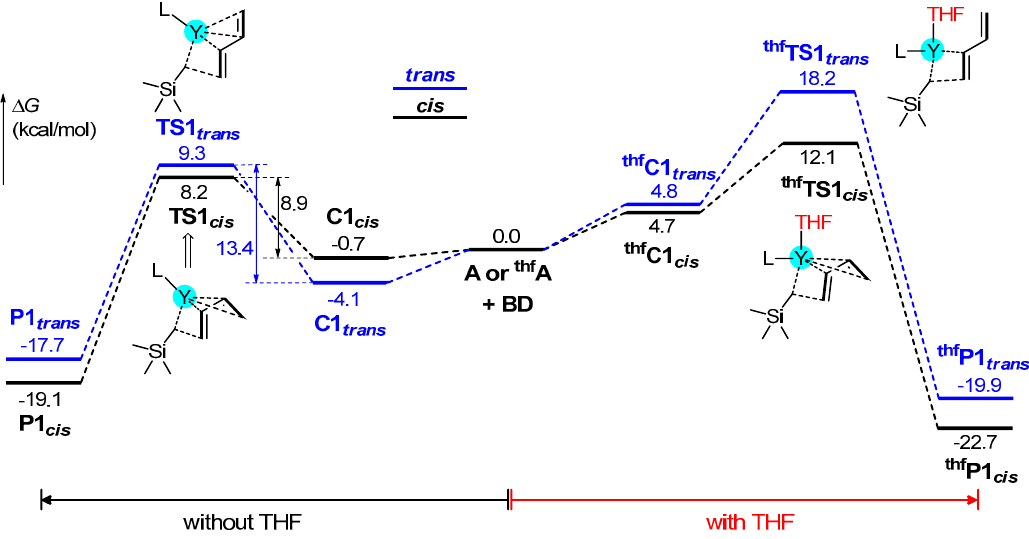
Figure 2. Computed energy profiles ( ∆ G in kcal/mol) for insertion of the first butadiene monomer into the Y–alkyl σ -bond of the cationic species thf A or A .